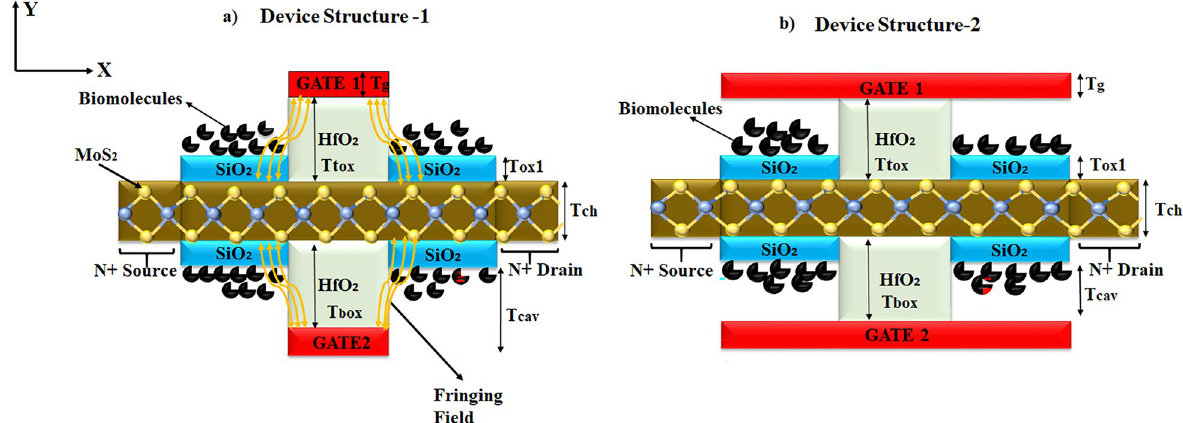
Figure 1. ( a ) Device structure-1 of dielectric-modulated, dual-gate, TMD FET (DM-DG-TMD-FET)-based Biosensor, and ( b ) Device structure-2 of DM-DG-TMD-FET-based